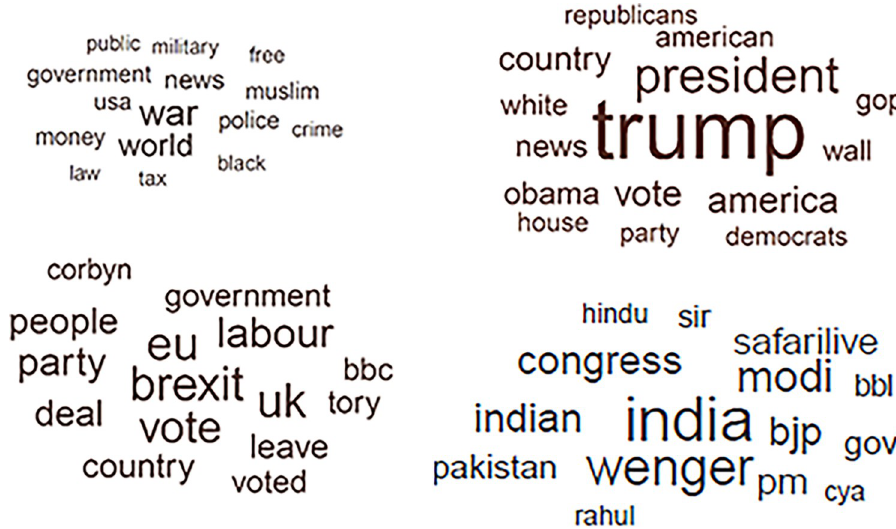
Fig 4. Topics related to politics. The larger the word, the higher the conditional probability of a word being in a topic.